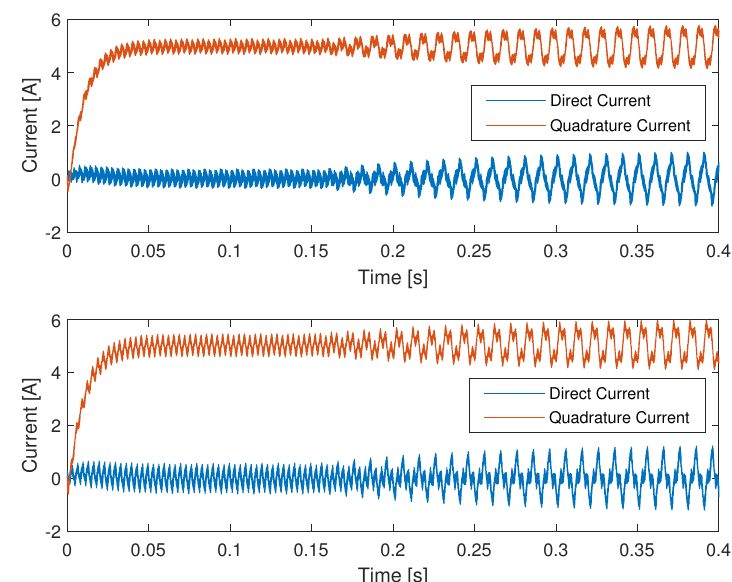
Figure 8. Direct and quadrature currents: for networked drive 1 and for networked drive 2.